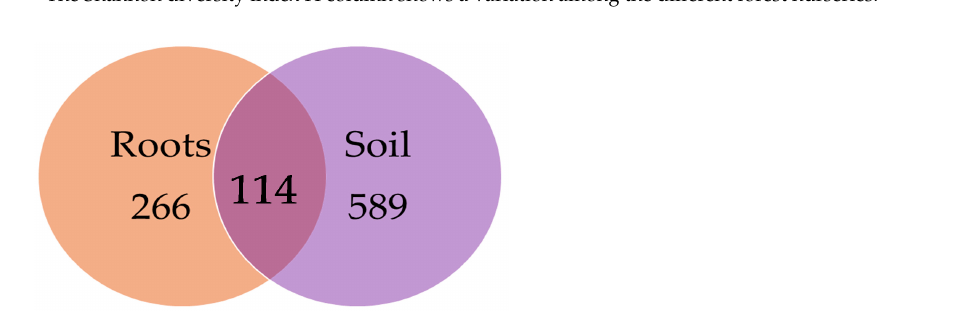
Figure 1. Venn diagram showing the diversity of the fungal OTUs found in the seedling roots and soil, and the number of fungal OTUs shared between both types of samples. The samples from different tree species and forest nurseries are combined.